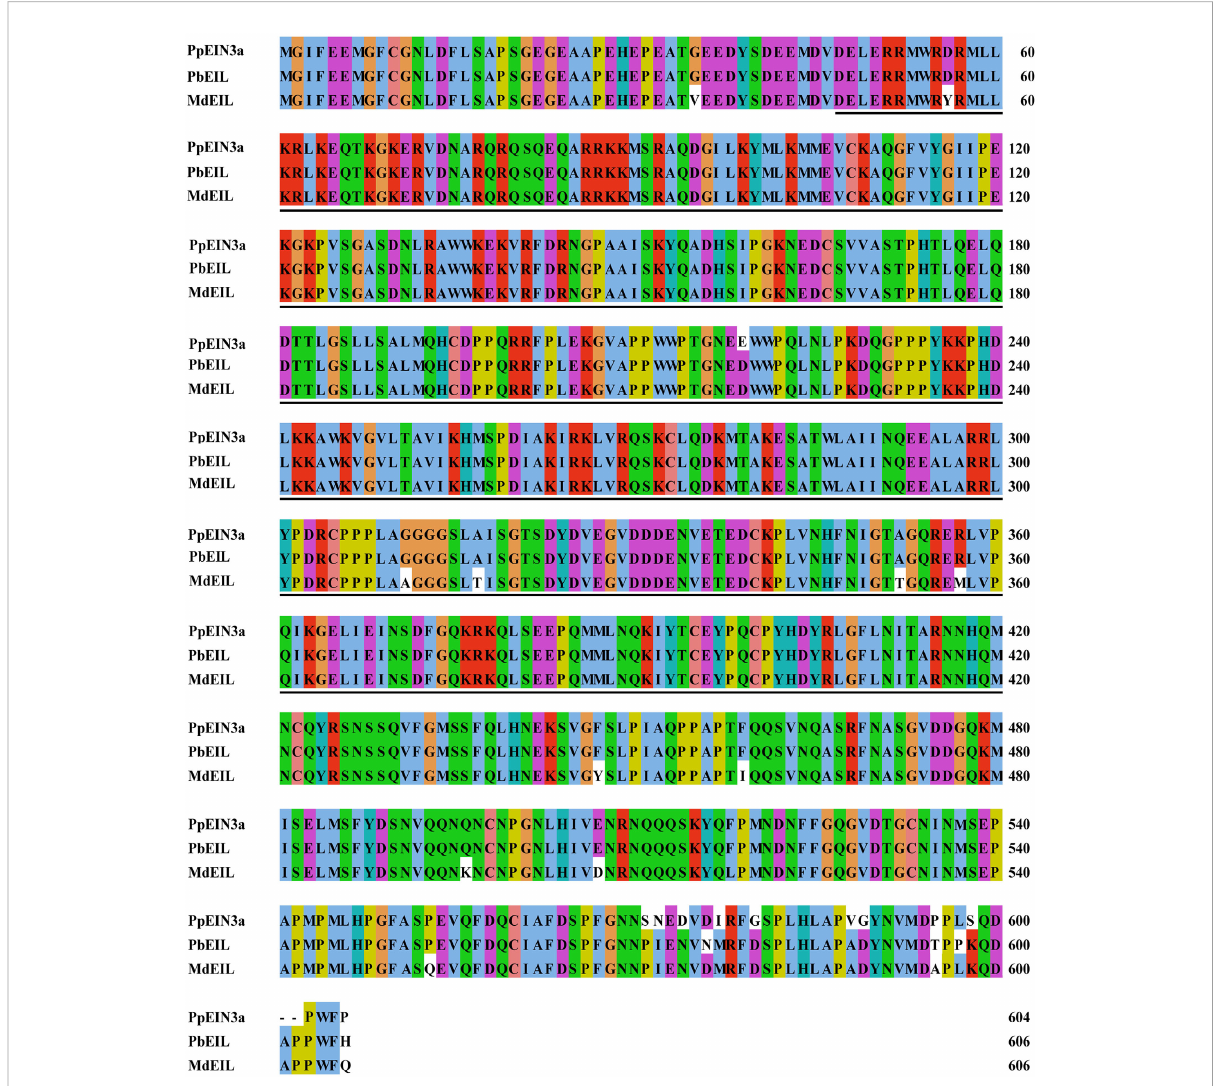
FIGURE 1 Sequence alignment among the three fruit EIN3/EIL proteins. The sequences of fruit EIN3/EILs were aligned. Amino acid substitutions and deletions are highlighted in white. The ethylene insensitive 3 (EIN3) domains are shown in underlines. The accession numbers of these fruit EIN3/EIL proteins in GenBank are KT726838 ( Pyrus pyrifolia PpEIN3a), XP_009355060 ( Pyrus x bretschneideri PbEIL), and XP_008346133 ( Malus x domestica